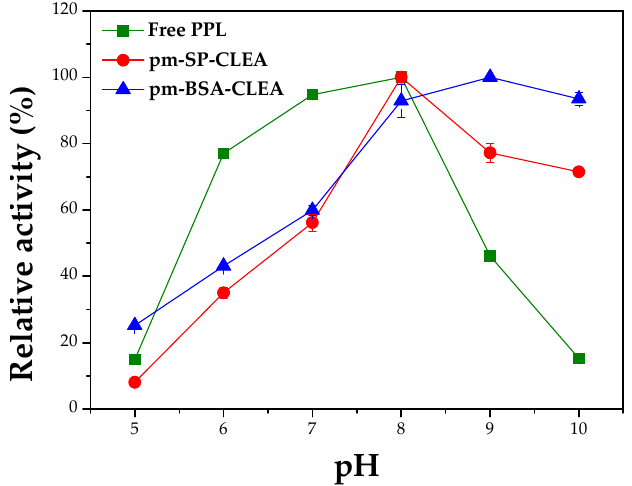
Figure 6. Profile of activity vs. pH for free and immobilized PPL. pm-(SP or BSA)-CLEA preparation conditions: treatment of PPL surface with dodecyl aldehyde (PPL/dodecyl aldehyde mass ratio of 1:1), aggregation/precipitation with ethanol (enzyme solution/ethanol volume ratio of 1:3) in presence of PPL/BSA/SMNPs or PPL/SP/SMNPs mass ratio of 1:1.5:1.5 and starch (0.8% w / v ) for 0.5 h, followed by treatment with glutaraldehyde (5 μ moles of glutaraldehyde/mg total protein) for 15 h at 4 °C under 150 rpm stirring, and treatment with alpha-amylase at 25 °C under 150 rpm stirring for 2 h. Activity assay conditions: hydrolysis of tributyrin (217.9 mM concentration) at 40 °C and different pH values for 5 min under 500 rpm stirring.